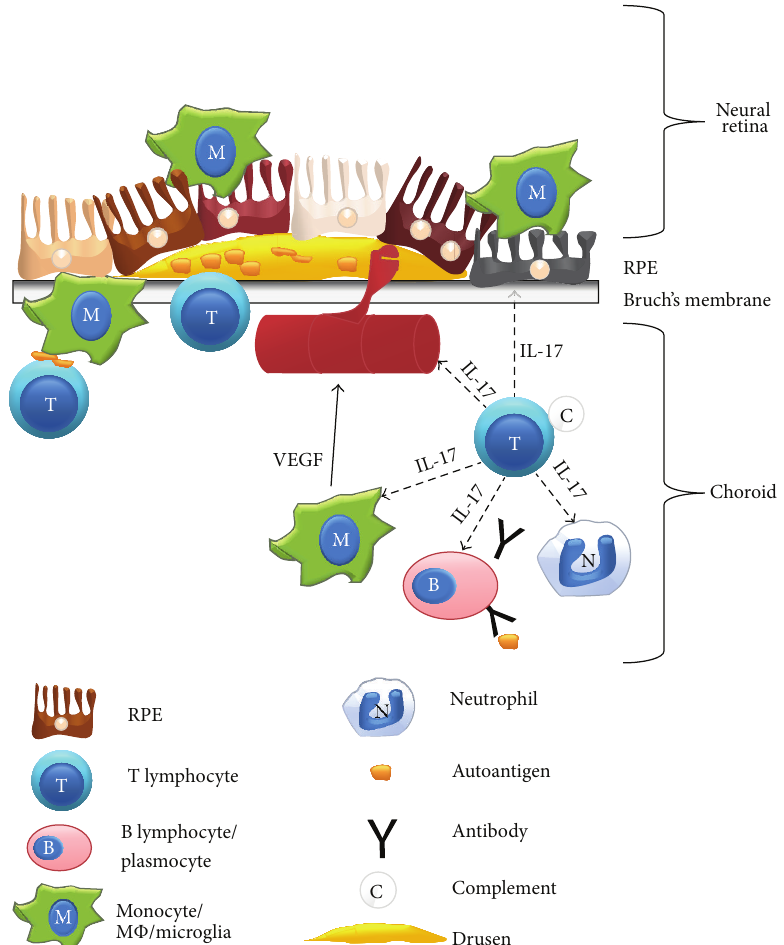
Figure 2: Potential mechanisms of action of autoreactive T cells and IL-17 in AMD. Antigen presentation by macrophages to autoreactive T cells could lead to alterations or the destruction of Bruch’s membrane and RPE by classical FAS-FASL interaction or granzyme/perforin production. Autoreactive T cells can also participate in AMD development via cytokines production. For instance, in the presence of complement proteins, T cells may produce IL-17. IL-17 is toxic to photoreceptors and RPE cells. IL-17 could also induce macrophages and neutrophils activation that can destroy RPE or produce proangiogenic factors (VEGF). In addition, IL-17 has been reported to be a proangiogenic molecule itself and can participate in choroidal neovascularization. Finally IL-17 and other cytokines produced by activated autoreactive T lymphocytes may induce the production of antibodies specific to RPE and retinal proteins. VEGF: vascular endothelial growth factor; RPE; retinal pigmented epithelium; location of the neural retina is mentioned but not